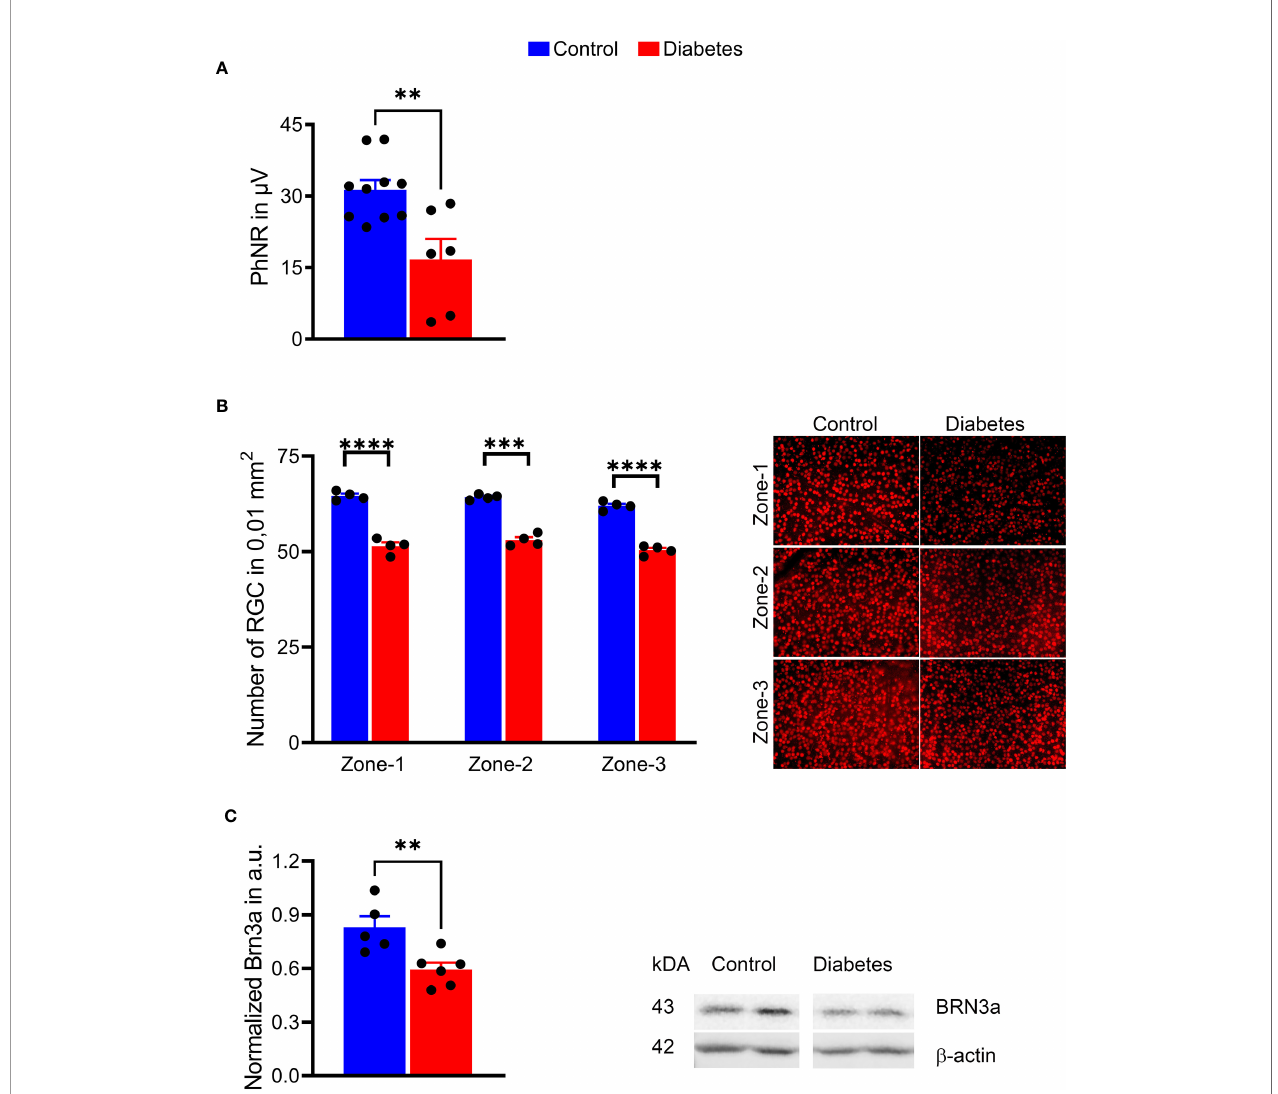
FIGURE 5 | Sustained hyperglycemia resulted in compromised RGC function. (A) The PhNR amplitudes were reduced by 50% in the diabetic retina (right panel). (B) Images of the retinal fl at mount processed with anti-BRN3A antibody (left panel). The number of BRN3A-positive RGCs in the diabetic retina was markedly reduced in zone 1, zone 2, and (zone-3 areas compared to the control group (right panel). See also Figure 4 for depicted area. (C) In agreement with the immunohistochemistry analysis, the expression of BRN3A protein was also diminished as detected by western blot analysis (representative membrane images on the left; calculated data on the right). **p < 0.01, ***p < 0.001, ****p < 0.0001, (n=